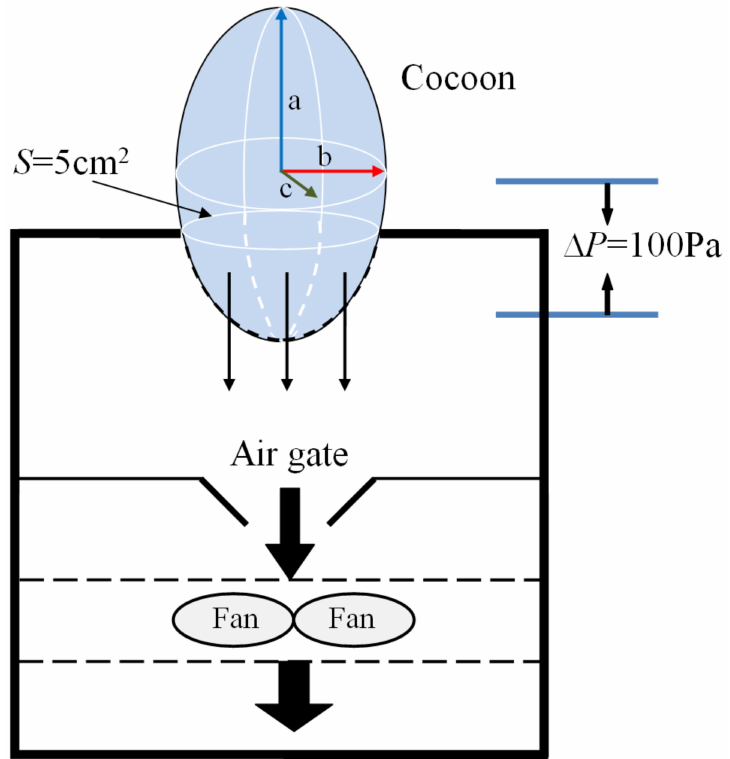
Figure 2. Schematic diagram of air permeability test of